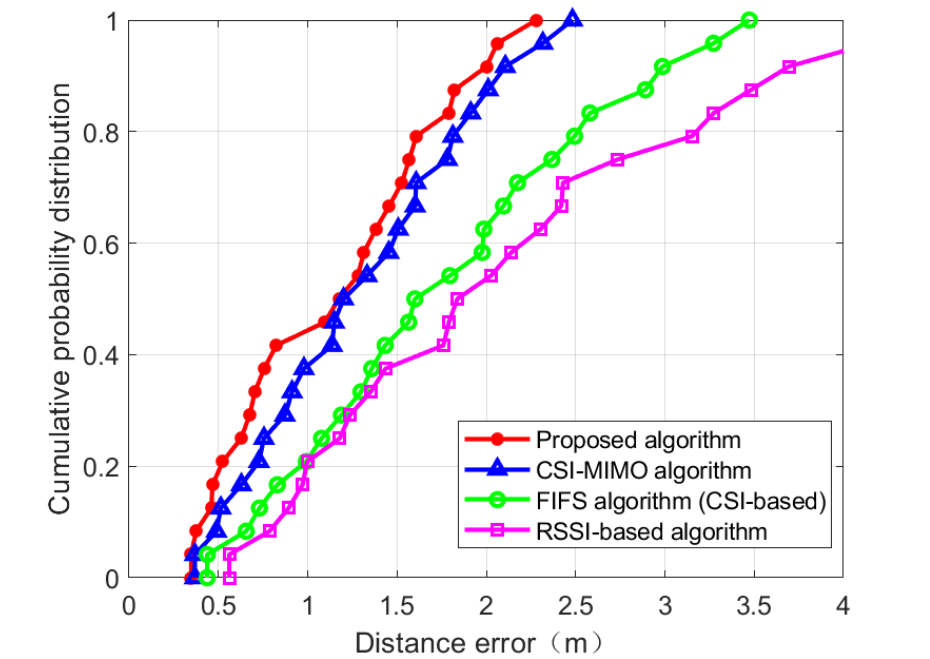
Figure 24. Comparing the cumulative distribution function (CDF) value of localization error of four algorithm in IT-1